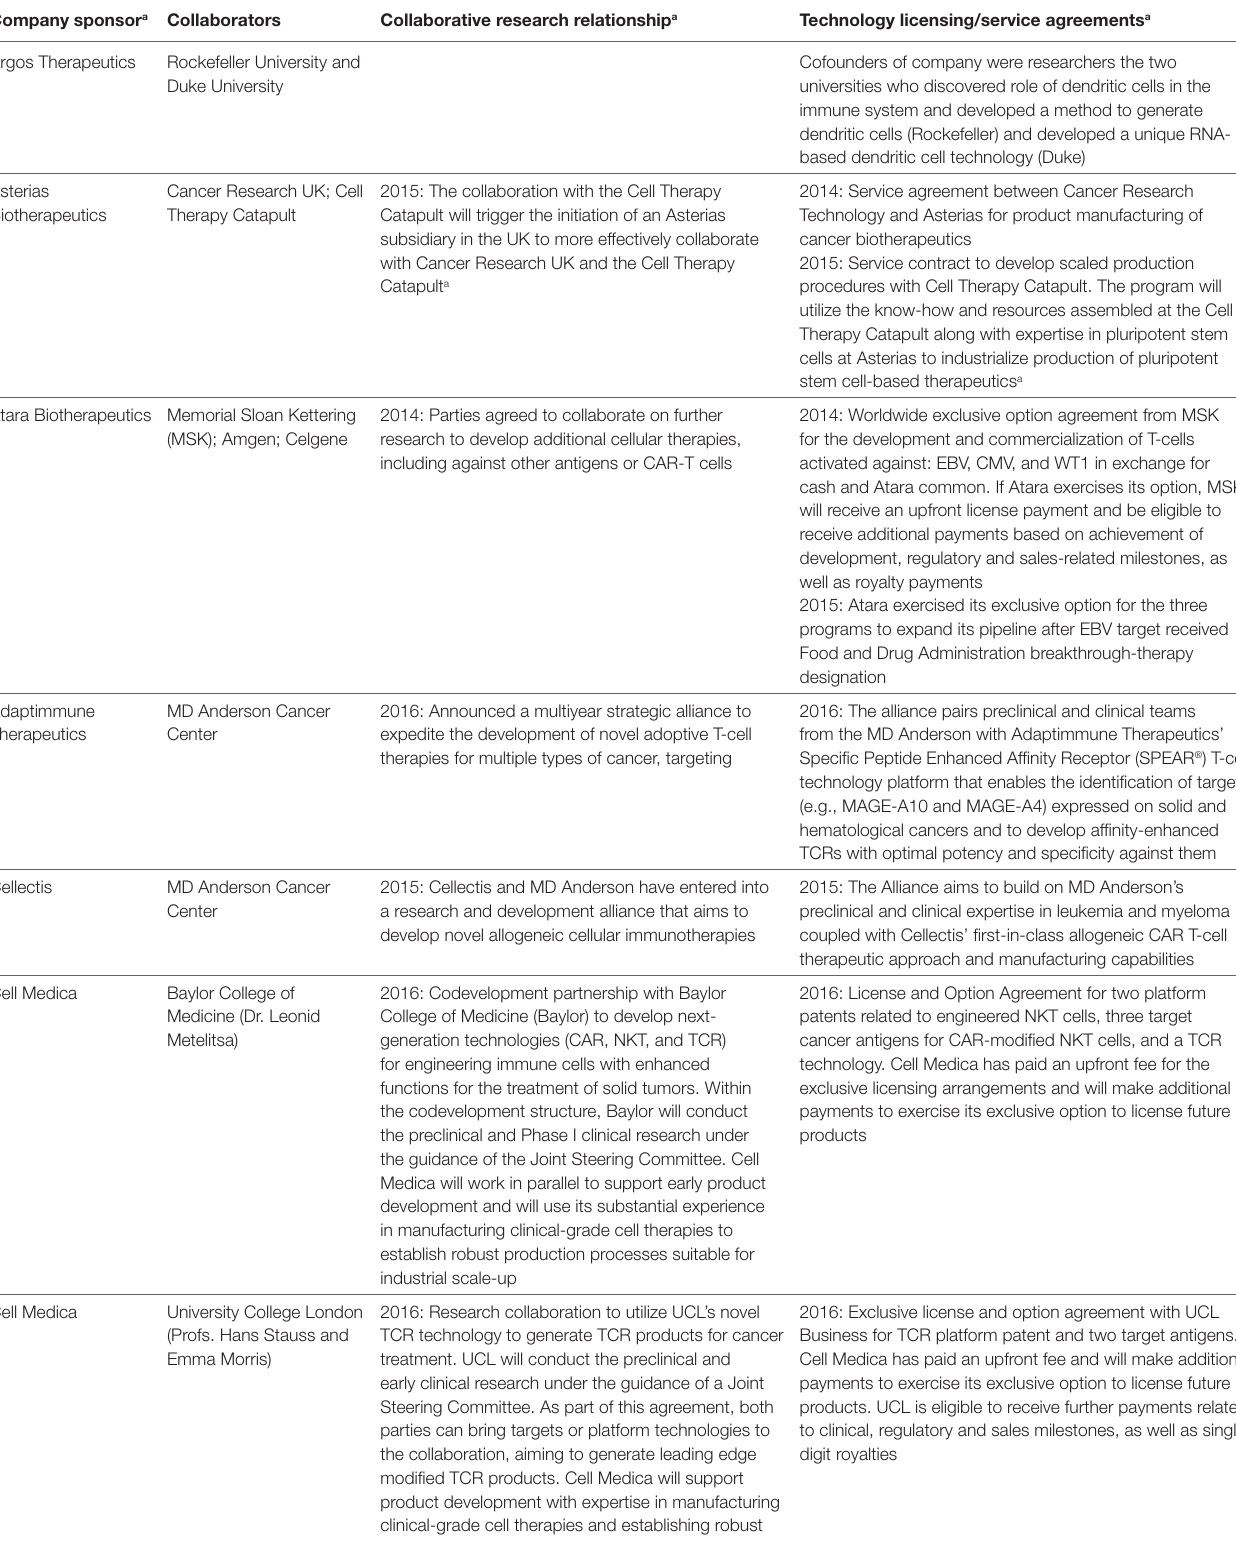
TABLe 2 | Nature of the relationship between companies and research institutions in the development of cancer immunotherapies. Company sponsor a